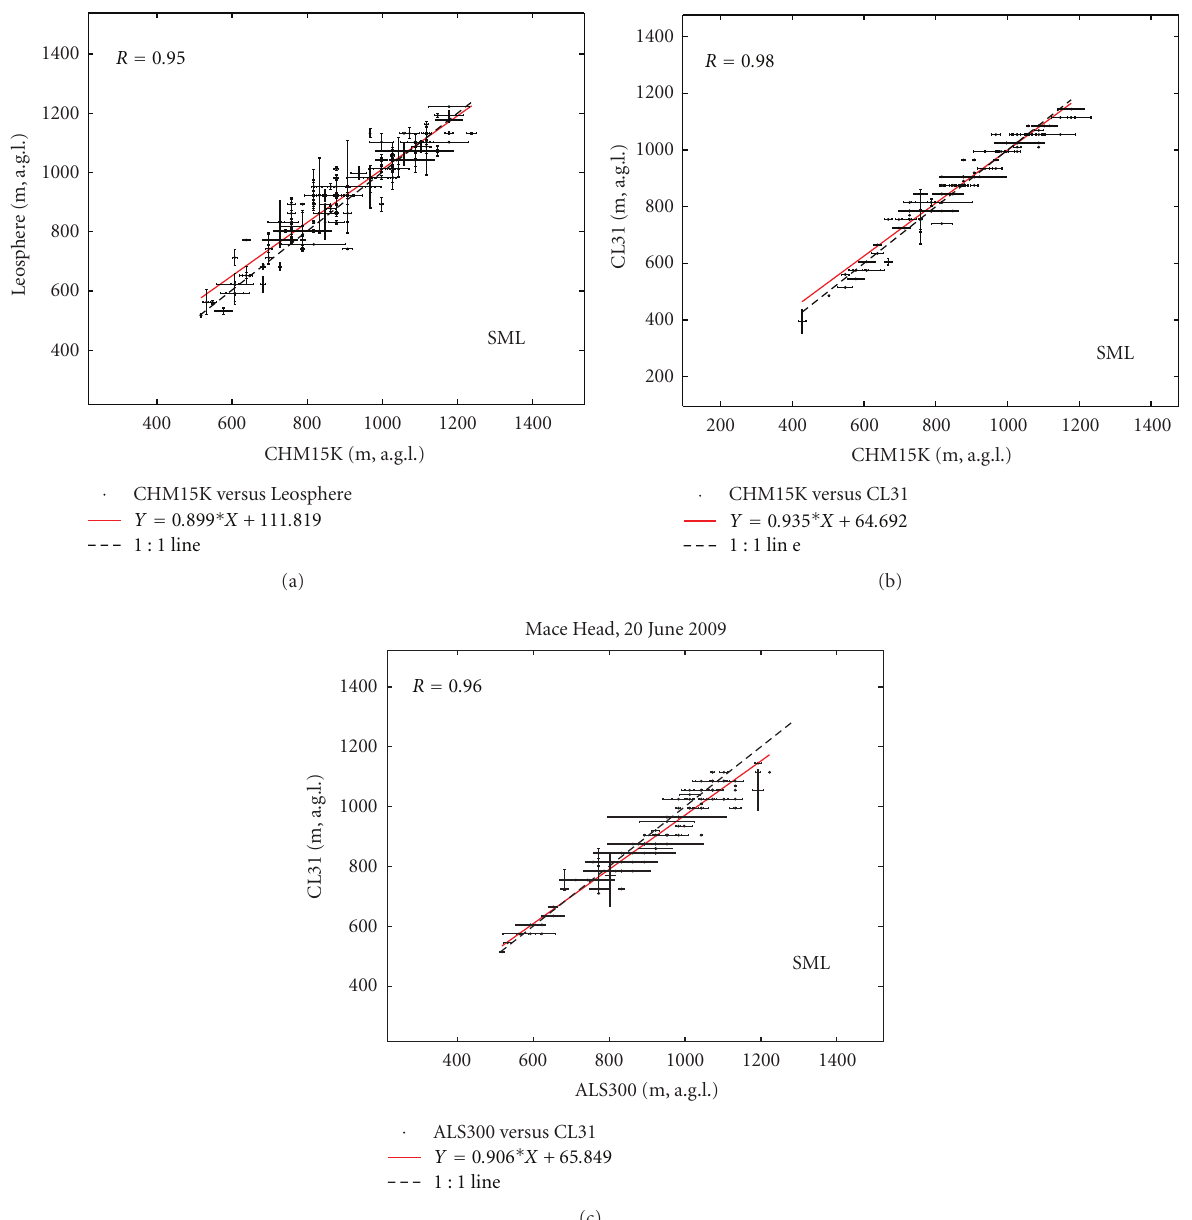
Figure 5: Linear correlations of SML detections on the 20th June 2009. (a) shows the comparison ALS300-CHM15K; (b) shows CL31- CHM15K; (c) shows CL31-ALS300. A filter has been applied for outliers > 2 σ stdv . Error bars have amplitude 2 σ THT